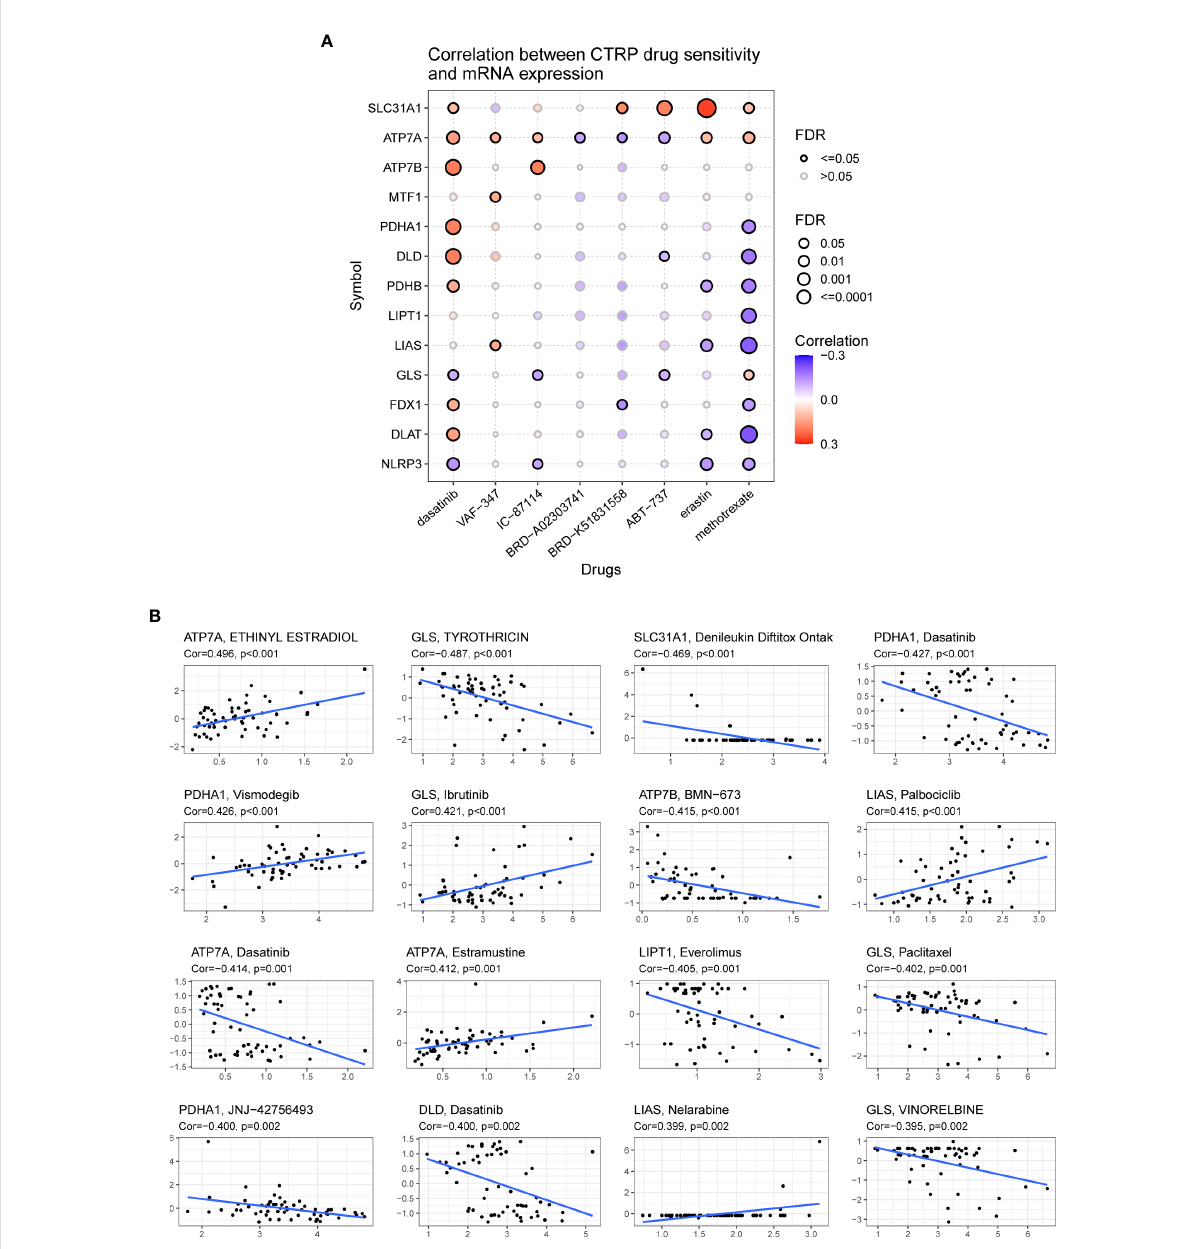
FIGURE 12 Association of the expression of cuproptosis-related genes with drug sensitivity. (A) Spearman correlation represents drug-related gene expression (GDSC). A positive correlation indicates that the gene is highly resistant to drugs. (B) The associations of cuproptosis-related genes expression and drug sensitivity based on CellMiner dataset, where the x- and y-axes represent gene expression and drug